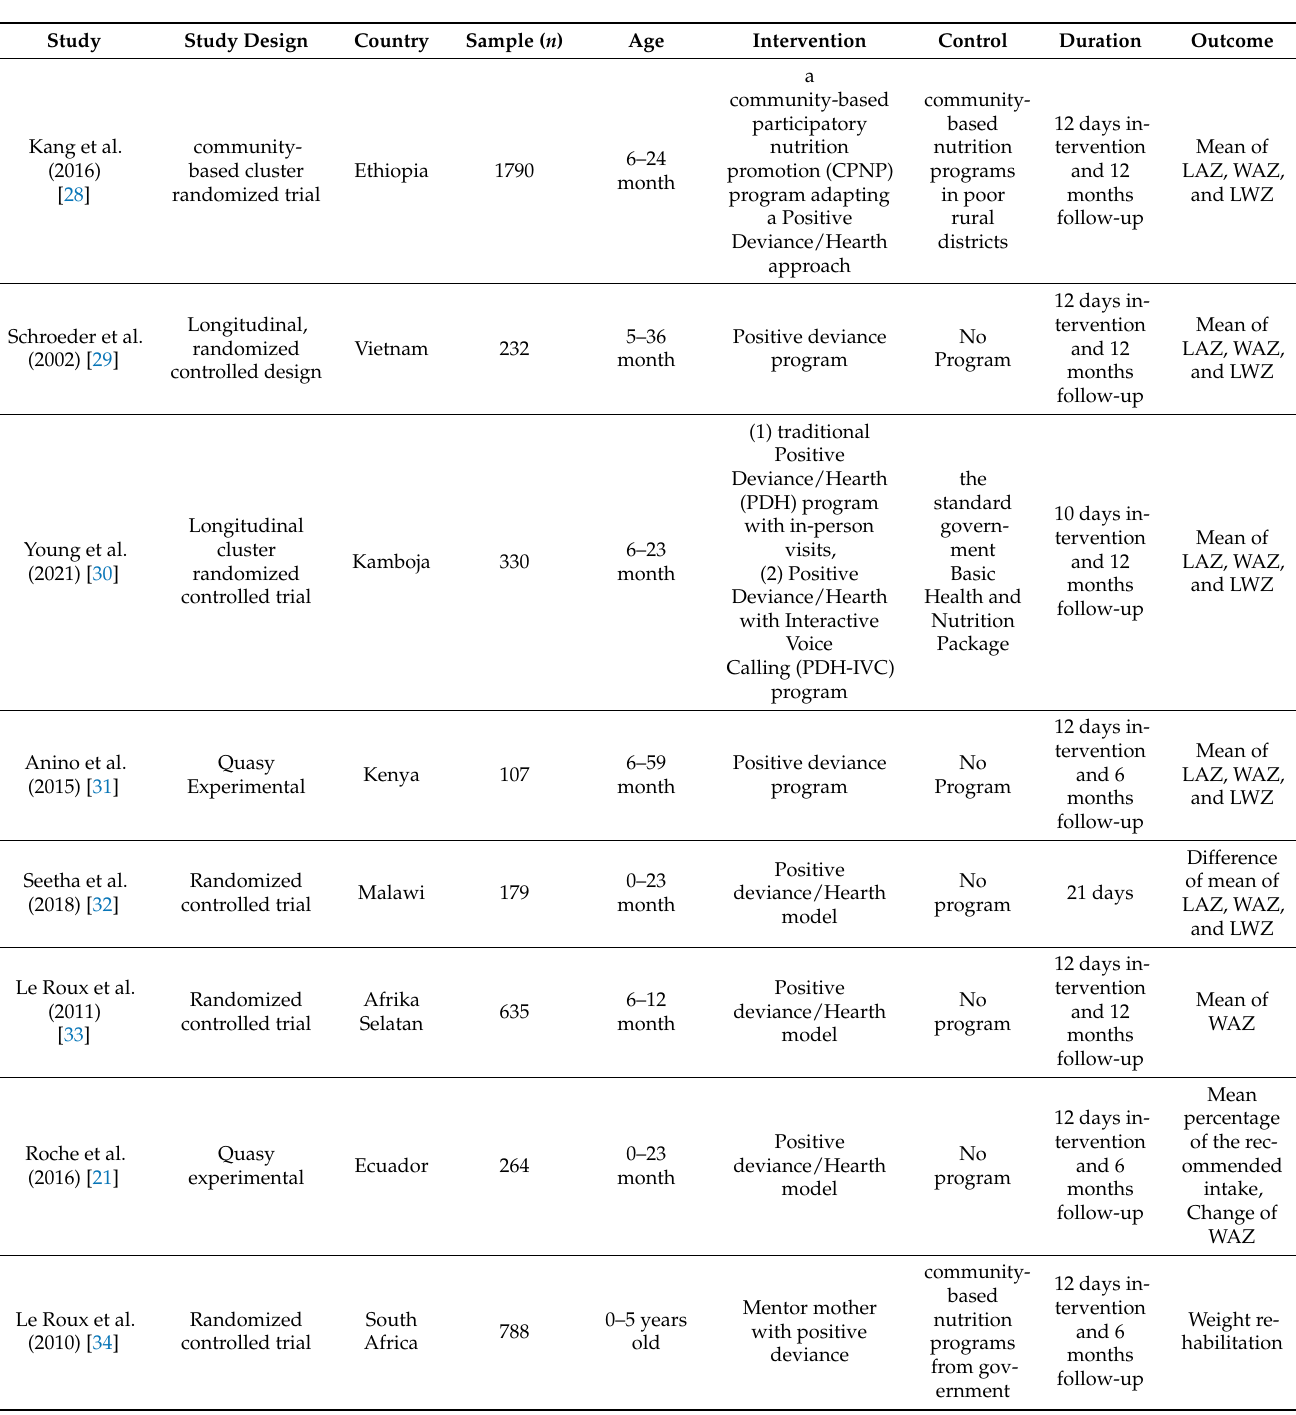
Table 2. Summary of findings from the included